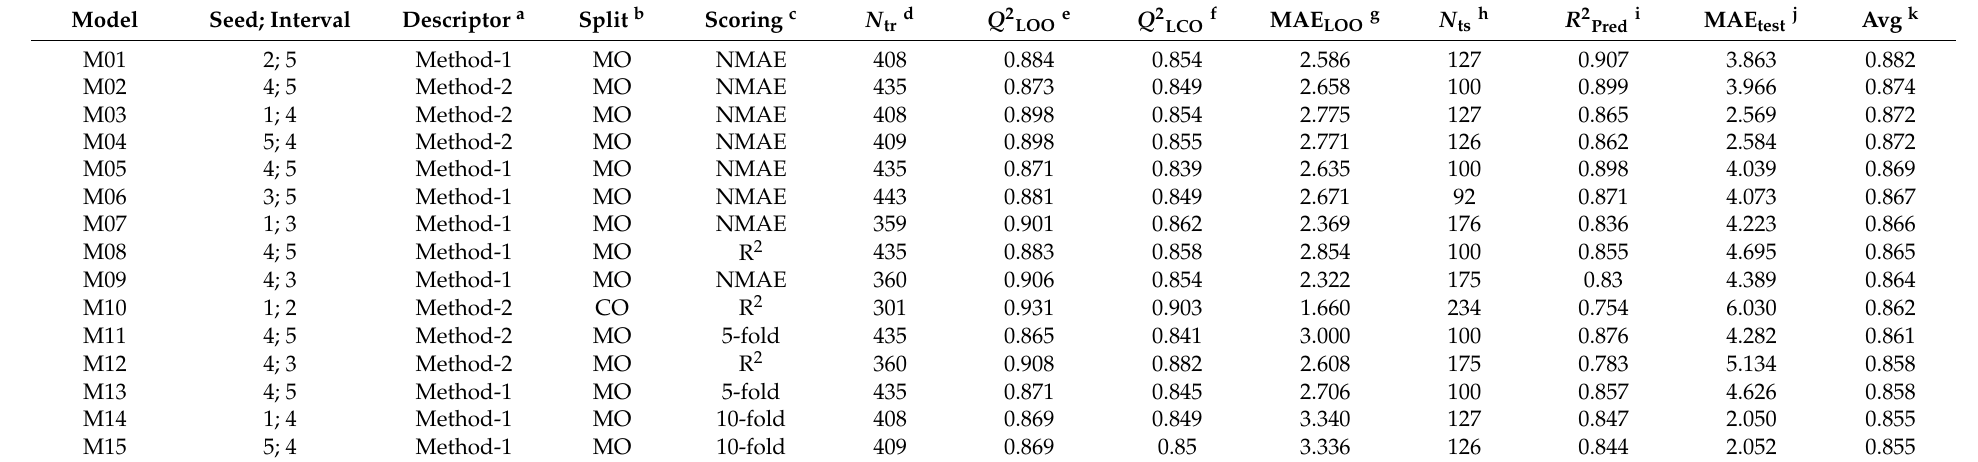
Table 1. Statistical results of the top 15 unique QSPR regression models